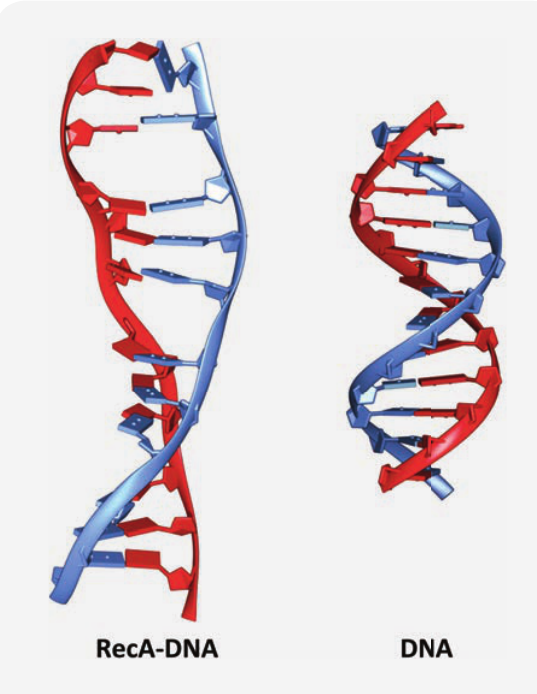
Figure 7. Answer is correct! Crystal structure of RecA-DNA (kindly adapted from results in Ref. 30 by Dr Anna Reymer) shows similar- ity to Σ DNA.